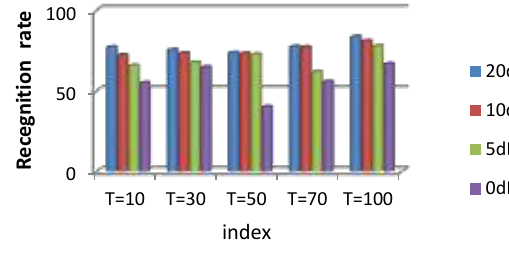
Figure 6. A comparative results to select the best index to be removed as it is shown T=100 has the best recognition rate.